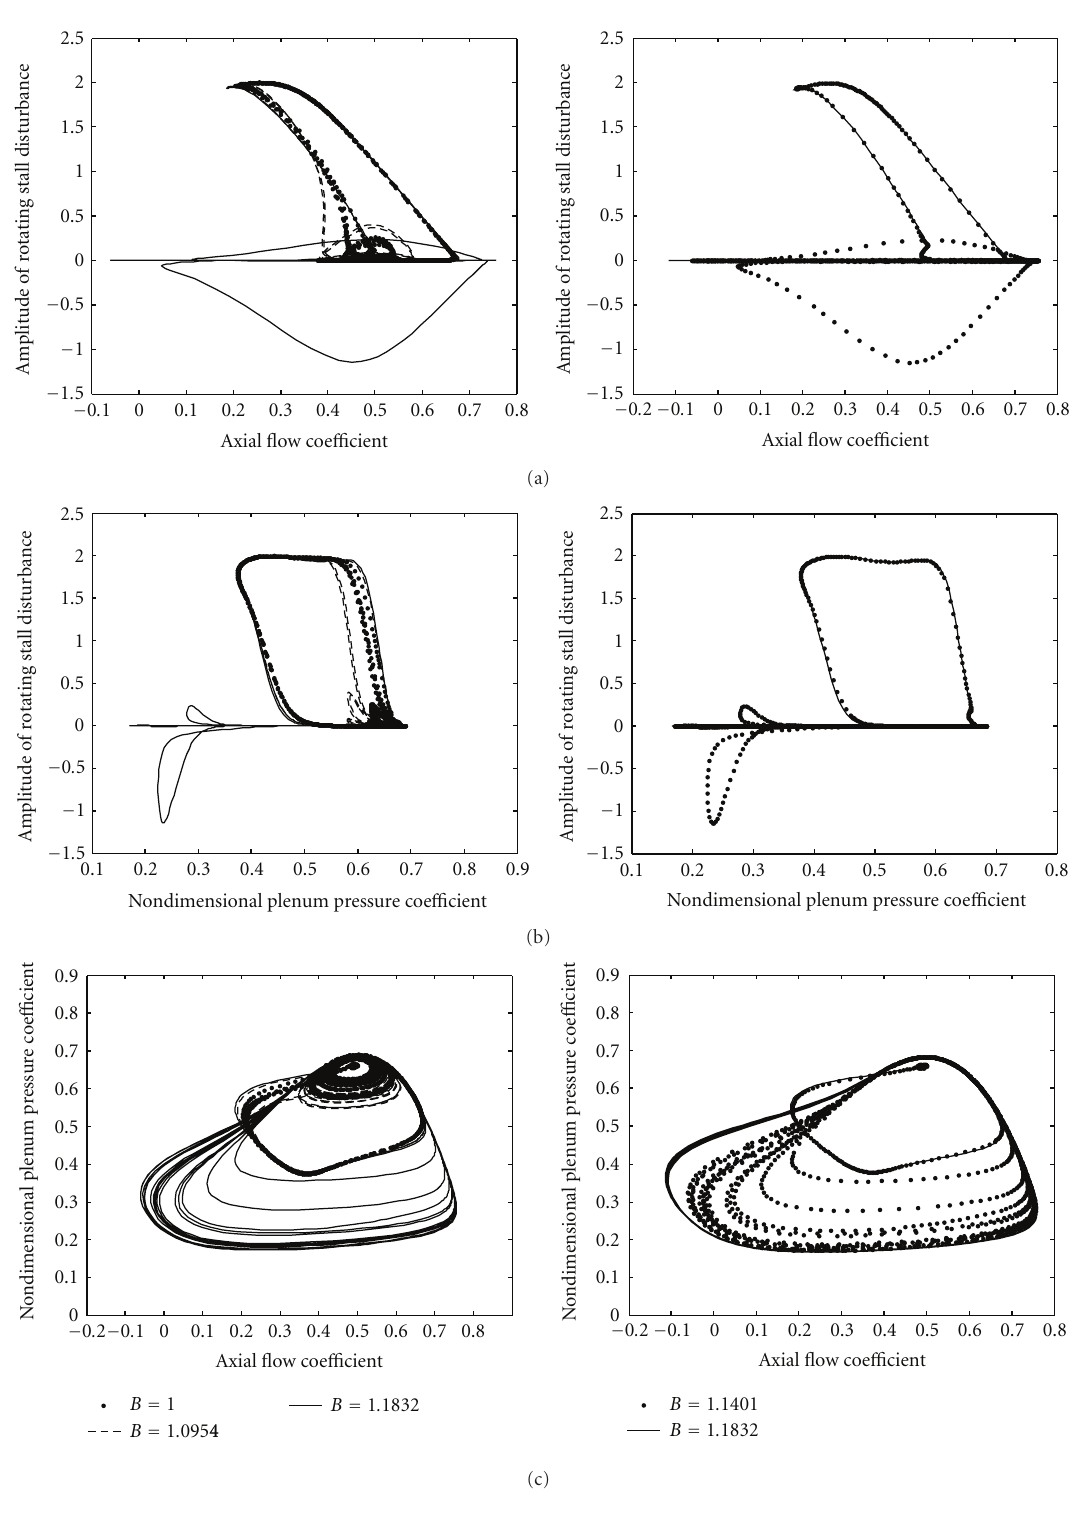
Figure 7: E ff ect of increase in plenum size: (a) variation of axial flow coe ffi cient with disturbance amplitude of rotating stall. (b) Variation of plenum pressure rise coe ffi cient with disturbance amplitude of rotating stall. (c) Limit cycle oscillation: axial flow coe ffi cient versus plenum pressure rise coe ffi